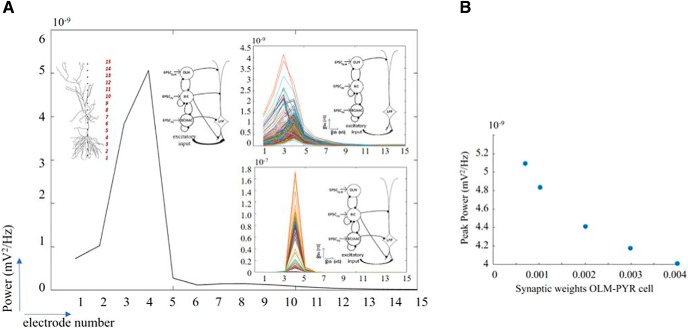
Laminar power and peak power changes with changing synaptic weights. A, Computed power at the different electrode locations to show laminar power distribution, for all sets of parameter values in the predicted regime. Top inset, Laminar power for OLM cell LFP component. Bottom inset, Laminar power for PV cell LFP component. Schematics shows the PYR cell model with the 15 extracellular electrodes and the different network configurations. B, Changing the synaptic weight from the OLM cells to the PYR cell does not lead to much change in the peak power, as illustrated by the peak power at electrode 4. Parameter values: gsb = 5.25, gbs = 5.00 nS. Synaptic weights of 0.00067, 0.001, 0.002, 0.003, and 0.004 μS are shown.